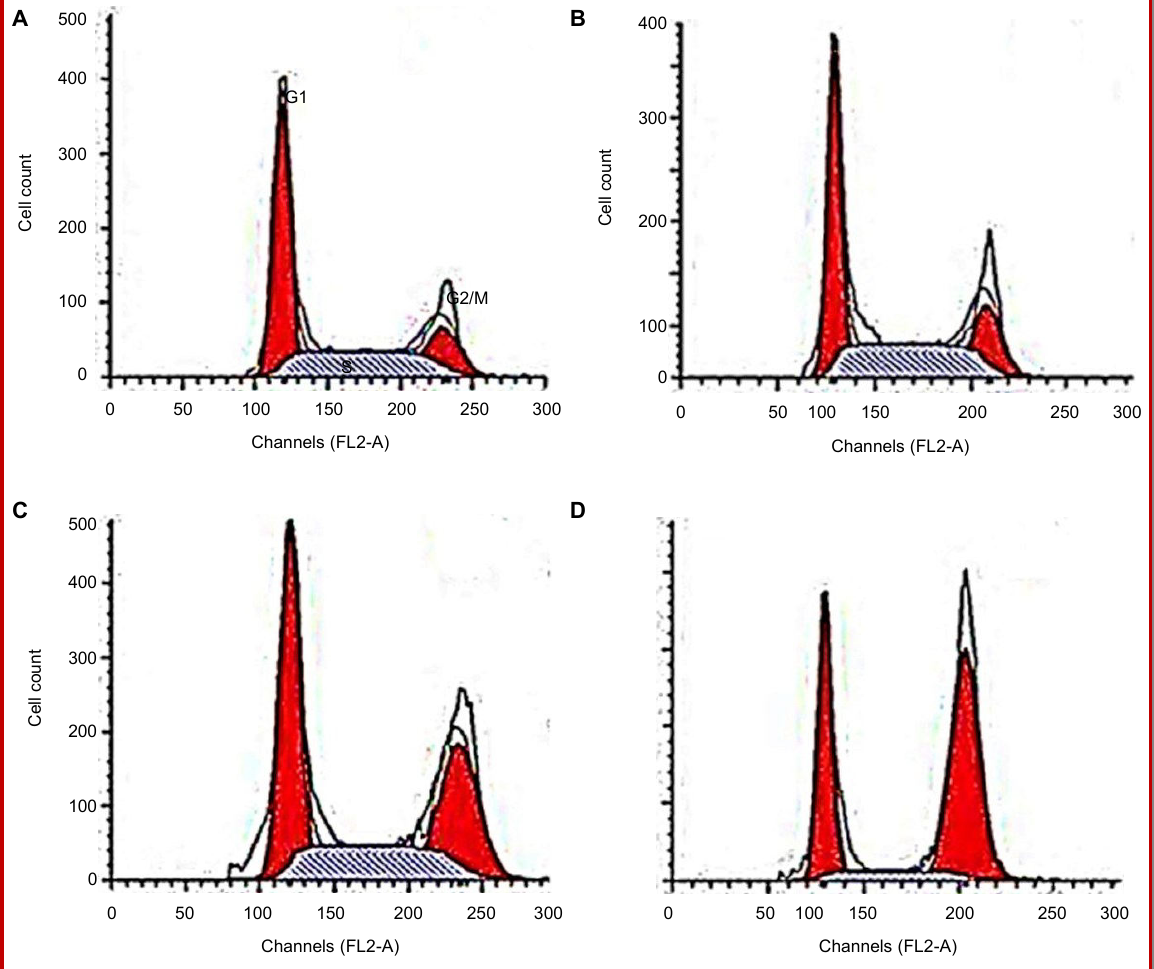
Figure 5: Eriodictyol induced G2/M phase cell cycle arrest in Hep-G2 liver cancer cells. The cells were treated with 0 (A), 10 (B), 50 (C) and 100 (D) µM eriodictyol for 48 hours and then analyzed by flow